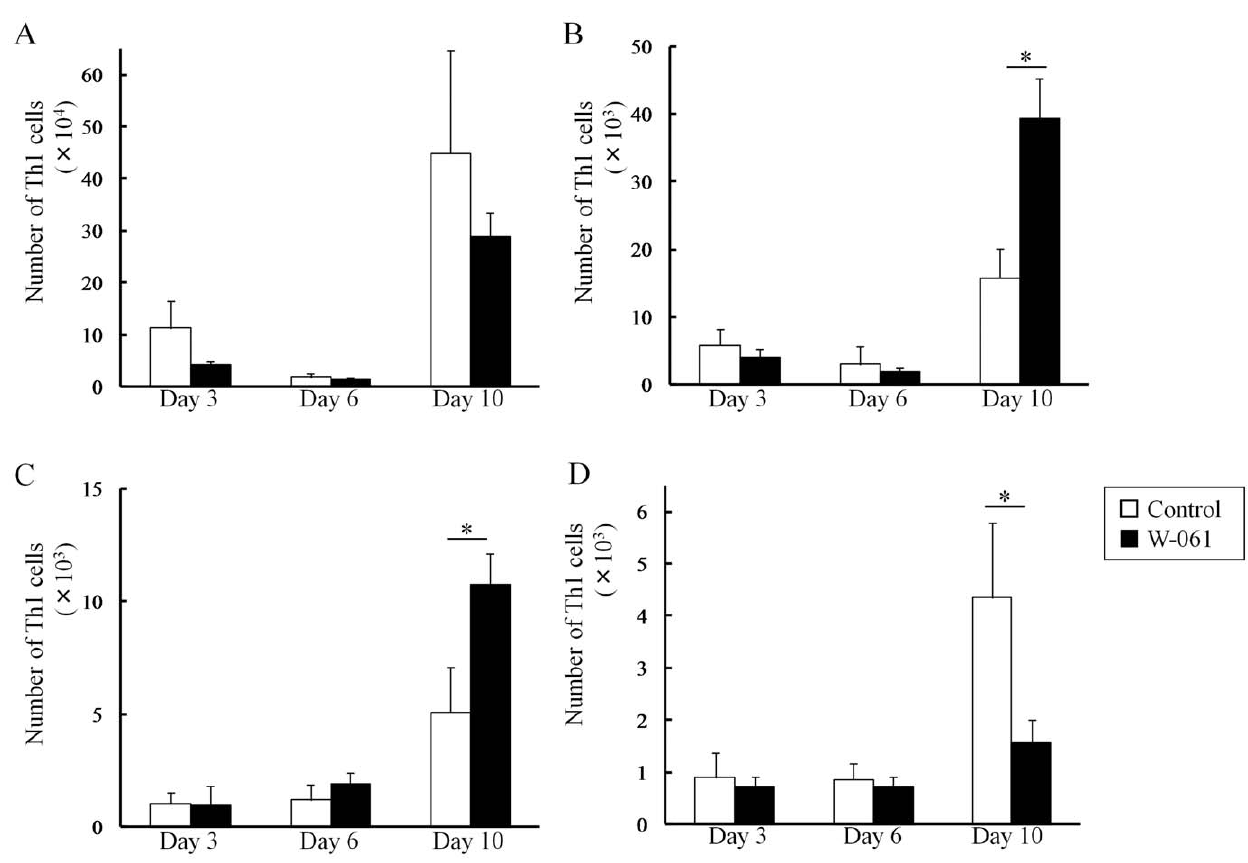
Figure 4. Change of the numbers of Th1 cells in (A) SP, (B) MLN, (C) PP and (D) LP. Data represent absolute values (means 6 SD, n=4 per group on days 3 and 6, n=6 per group on day 10, * p , 0.05).